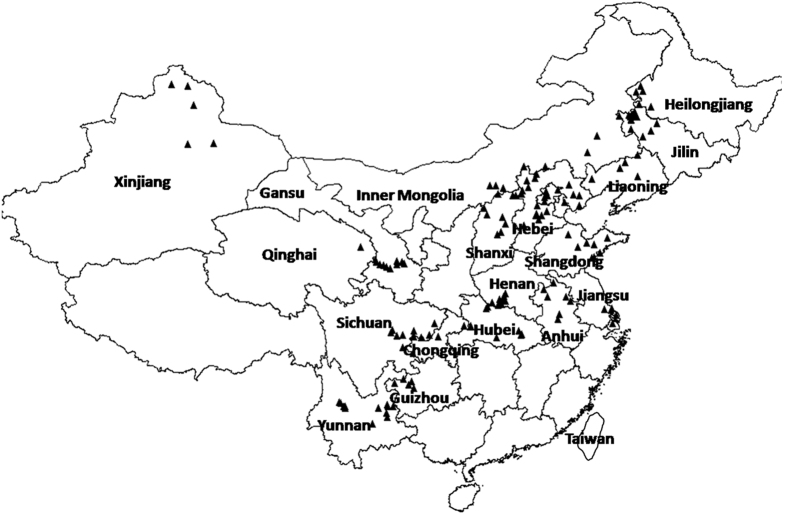
Map of soil samples collecting sites in Greater China created by DIVA_GIS (v7.5) software.Hijmans, R.J., Guarino, L., Mathur P. DIVA-GIS. Version. 7.5. http://www.diva-gis.org/ (2012) Data of access: 05/07/2015.